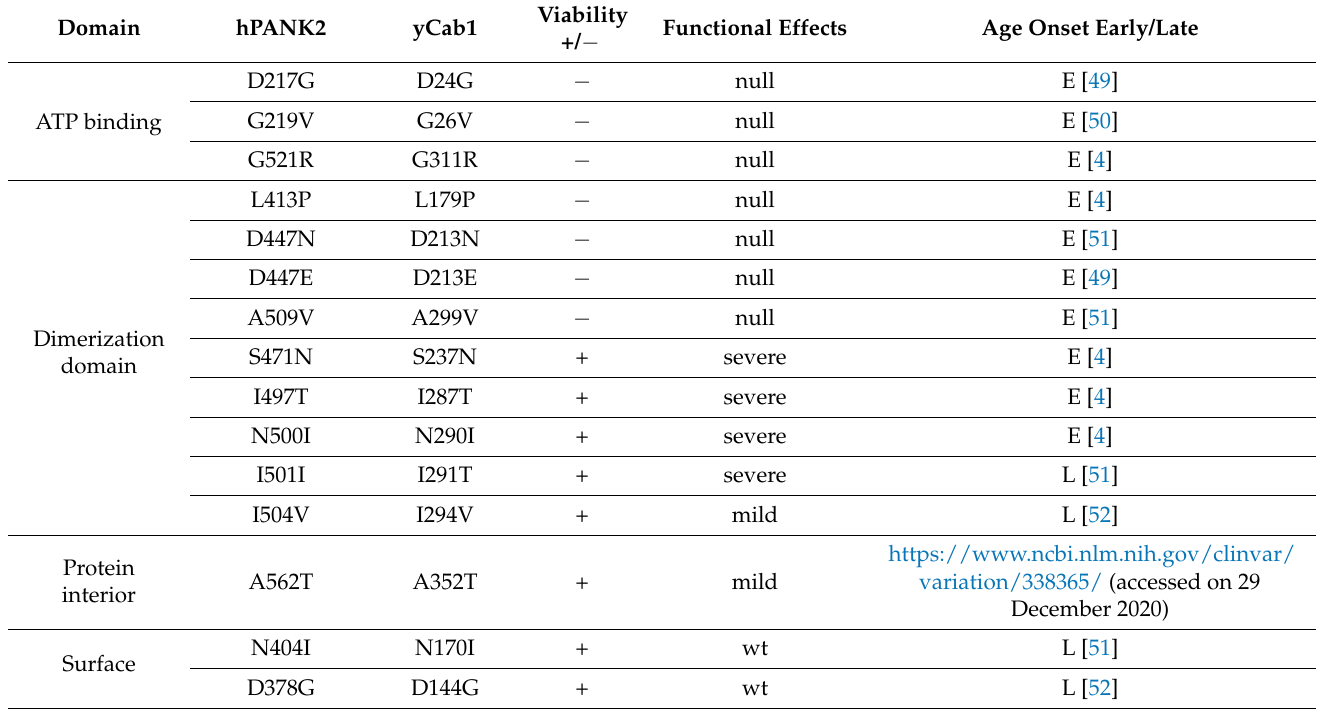
Table 1. List of the missense mutations studied. For each mutation we indicated the ability (+/ − ) to complement the lethal phenotype of ∆ cab1 and their effect on respiratory function. The age of onset (early/late) and the corresponding reference are also indicated. Viability Domain hPANK2 yCab1 Functional Effects Age Onset +/ −